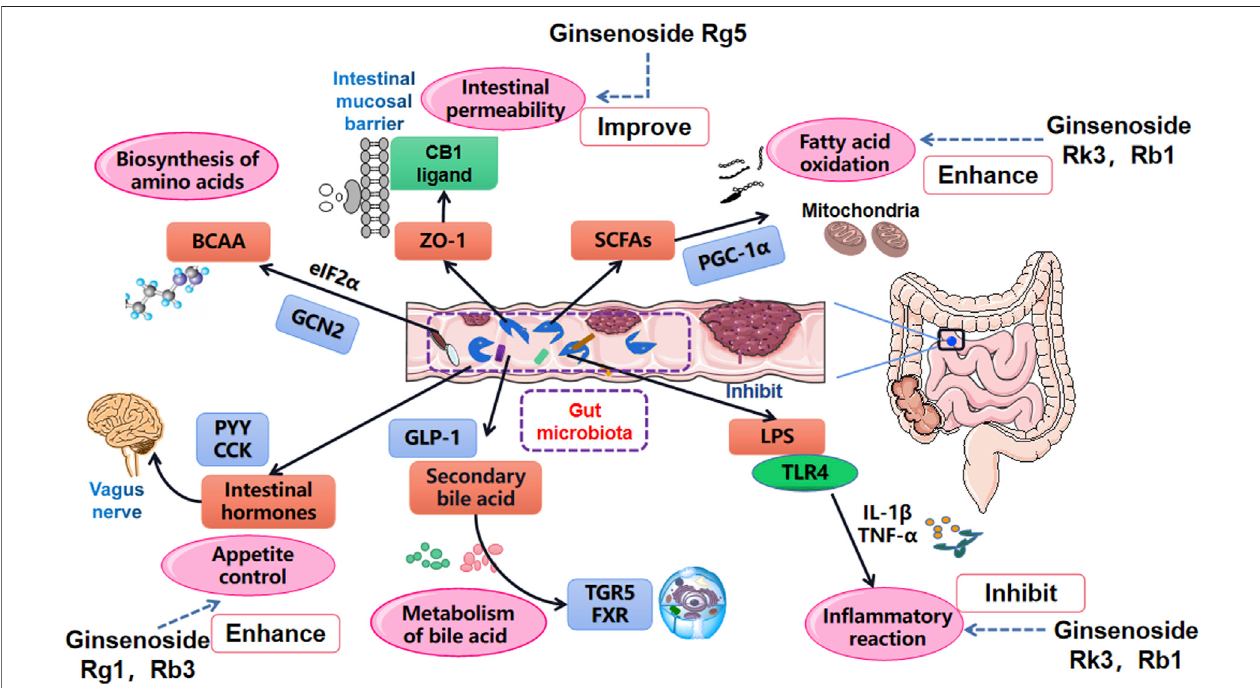
FIGURE 3 | Main in fl uential pathways for obesity improvement via the role of gut microbiota manipulation. Gut microbiota affects the oxidation of SCFAs, the absorption of LPS and in fl ammation level, changes intestinal mucosal permeability by acting on tight junction protein ZO-1, manages the metabolism of bile acids by regulating TGR5 and FXR, in fl uences the metabolism of BCAA and release of intestinal hormones.